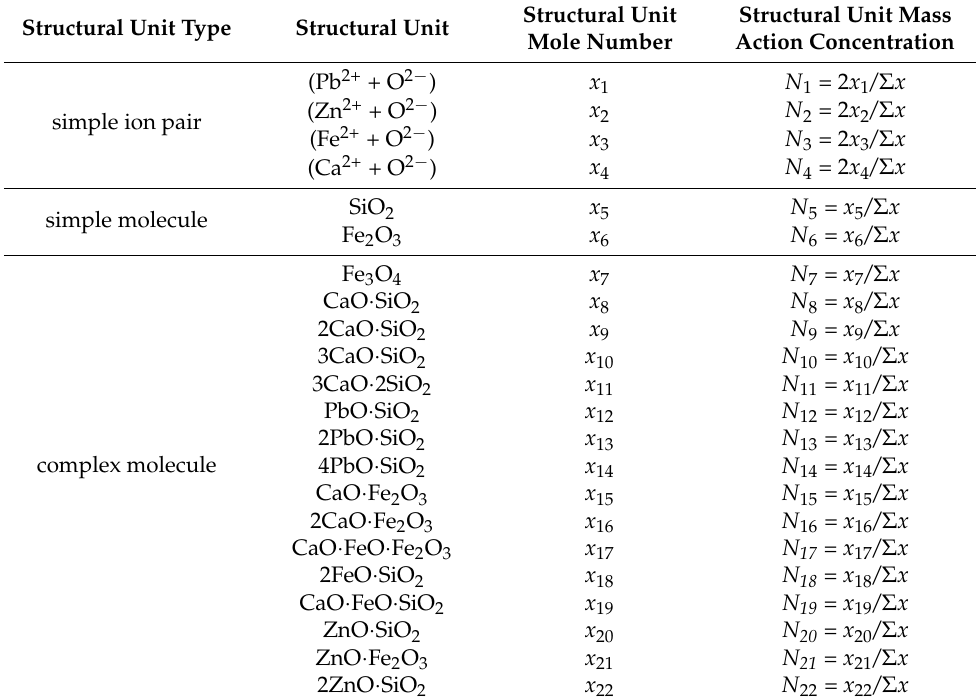
Table 2. Molarity and mass action concentration of each structural unit in the slag. Structural Unit